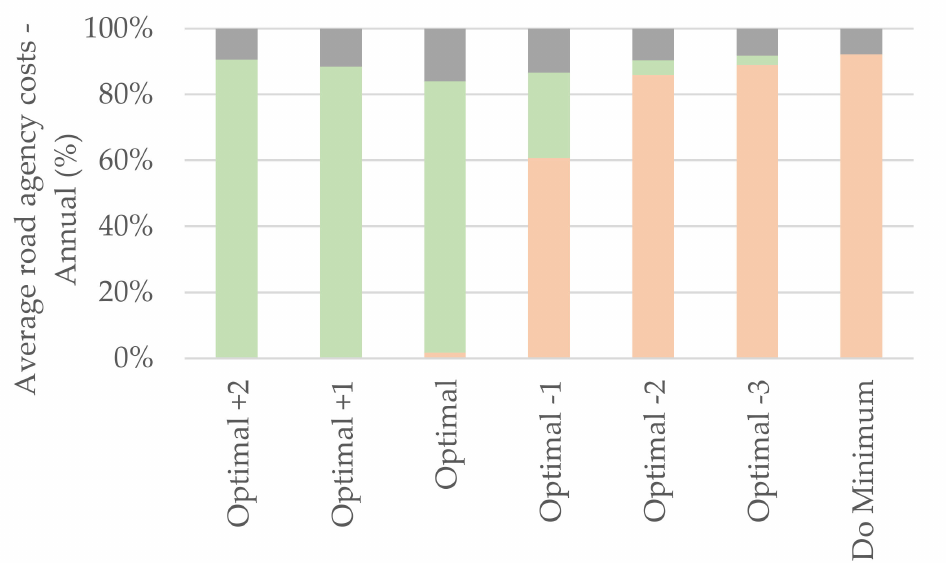
Figure 5. Annual average road agency costs for each maintenance strategy (%).